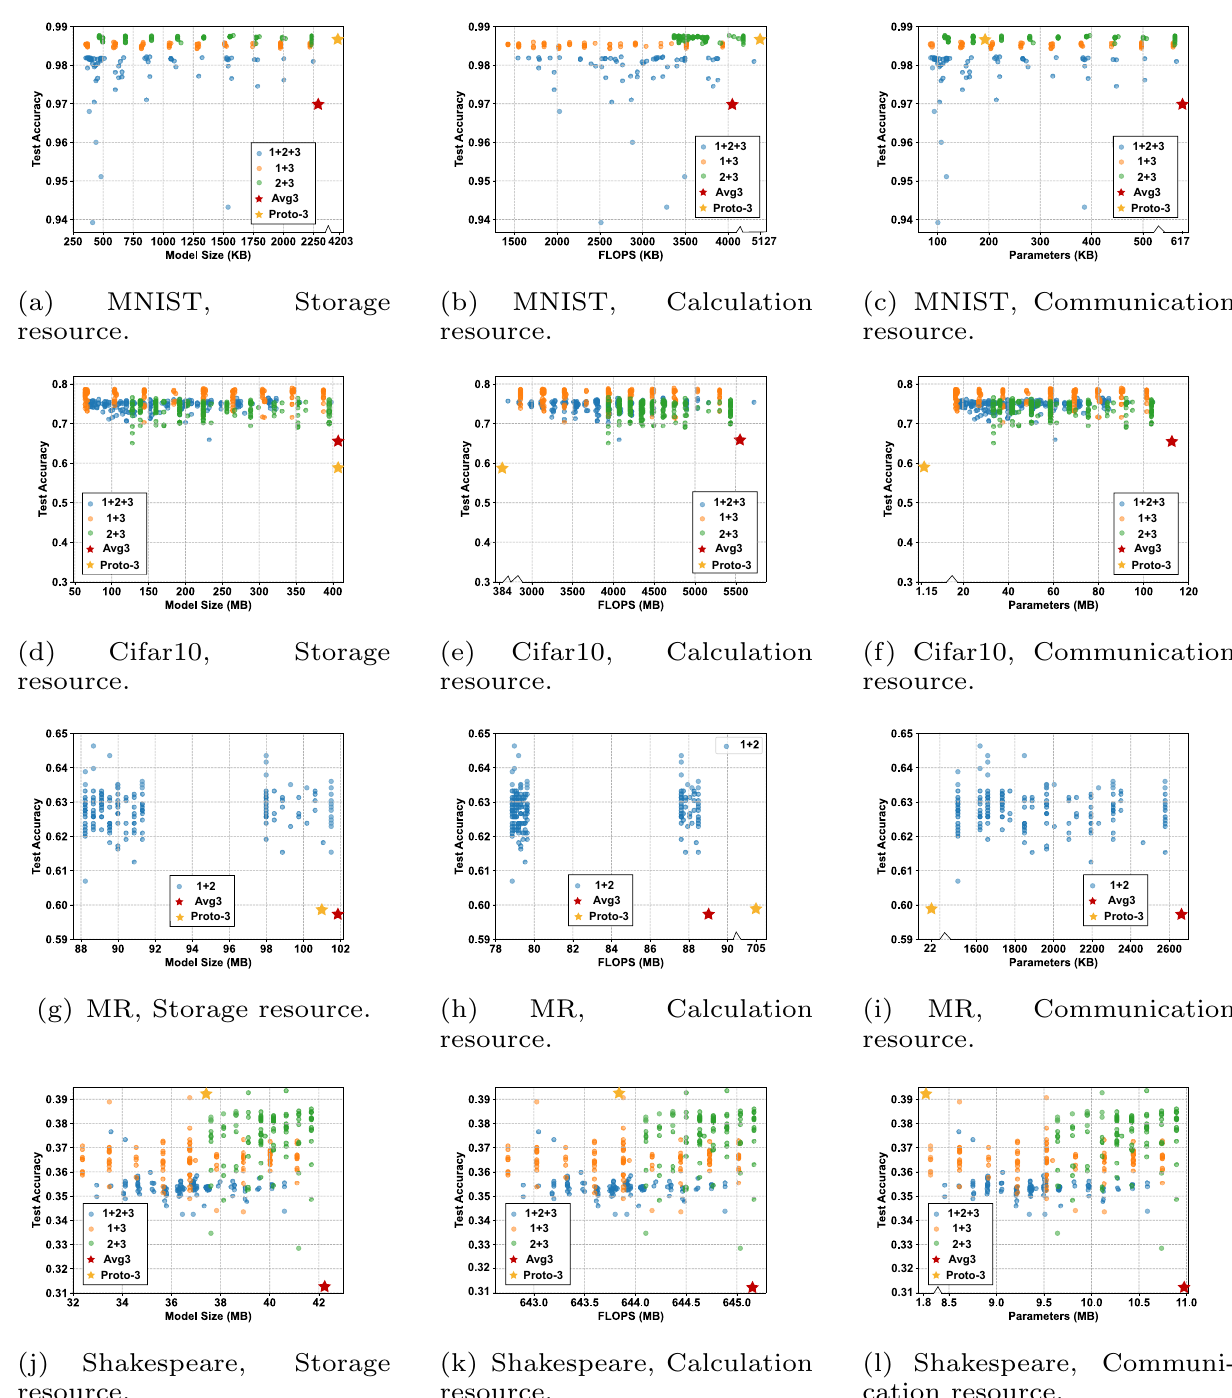
Fig. 9 Scatter figures of test accuracy vs. resource overhead for different